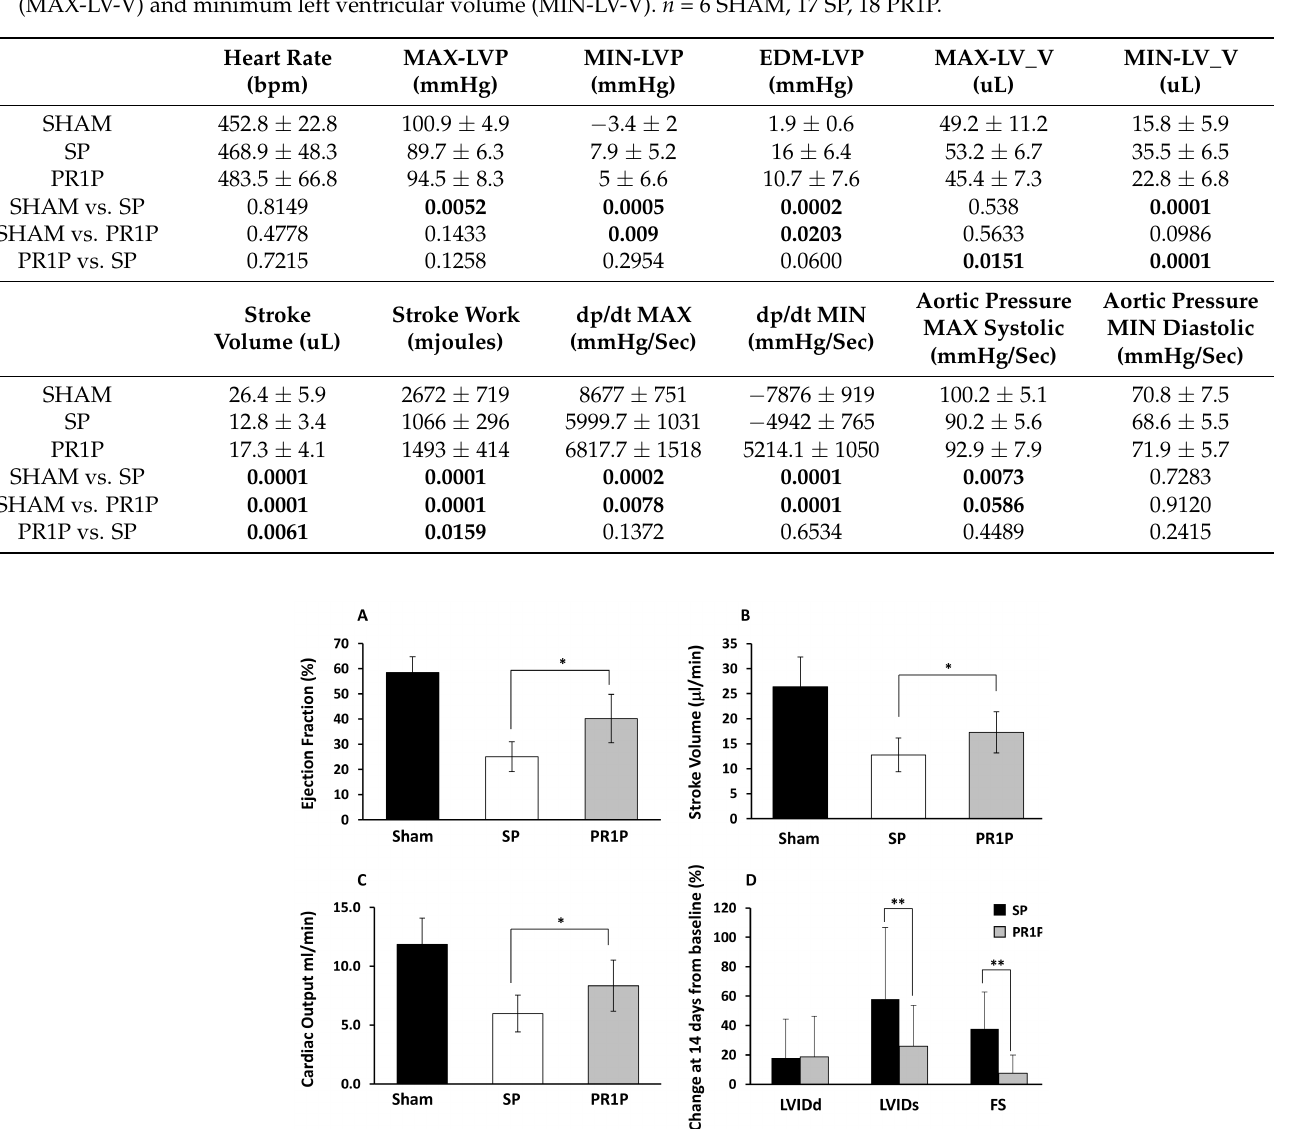
Table 1. PR1P enhances functional outcome of the heart following myocardial infarction in mice. Shown are hemodynamic parameters and indices of heart function (with p values comparing groups as indicated) in mice obtained using vascular transducer catheters placed in the left ventricle of anesthetized animals 14 days following sham surgery (SHAM) and no treatment, or left coronary artery ligation and every other day treatments with intraperitoneal injections of PR1P or scrambled peptide (SP). Beats per minute (BPM), maximum left ventricular pressure (MAX-LVP), minimum left ventricular pressure (MIN-LVP), minimum end diastolic left ventricular pressure (EDM-LVP), maximum left ventricular volume